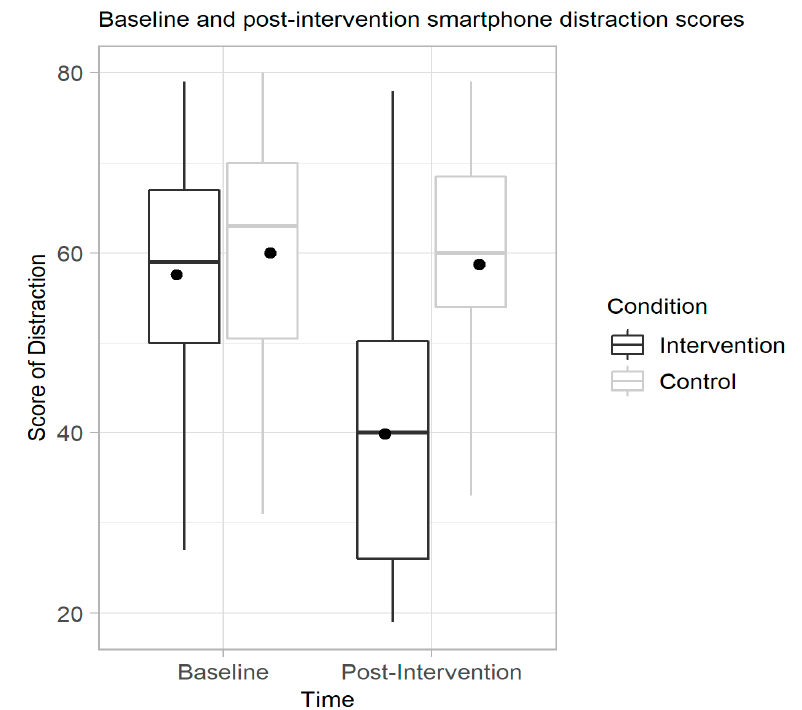
Figure 2. Per protocol smartphone distraction outcomes before and after the intervention.